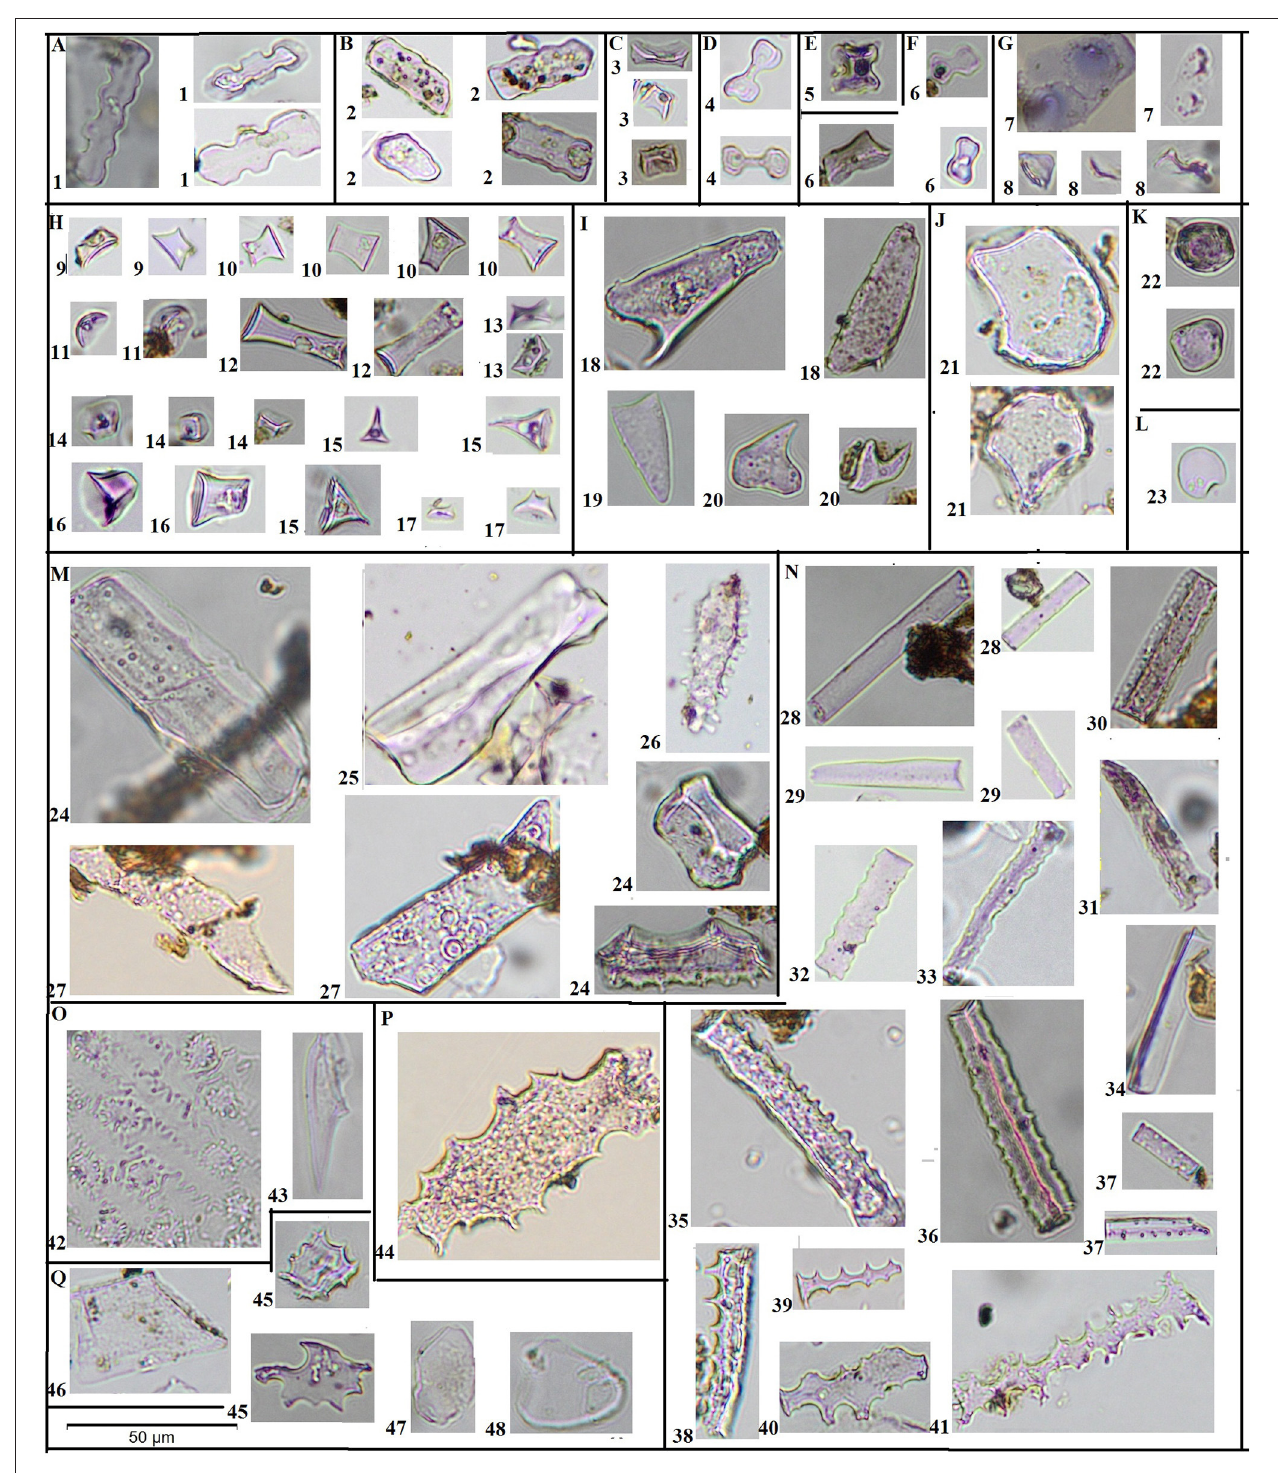
FIGURE 2 | Microphotographs of morphotypes. Microphotographs of all phytolith morphotypes used in this study. Scale bar = 50 µ m and applies to all photographs. A1—polylobate trapeziforms; B2—wavy plates; C3—saddles; D4—True bilobates (Panicoid); E5—cross (symmetrical quadrilobate); F6—trapeziform bilobate (“ Stipa -type”); G7 conical of Carex , G8—conical with wavy bottom, H—rondels, including H9—low conical rondel, H10—tall conical rondel, H11—spherical bottom rondel, H12—elongated rondel; H13—saddle-top rondel; H14—low trapezoid (pyramidal) rondel; H15—single-keeled rondel; H16—tall trapezoid (pyramidal) rondel; H17—multiple keeled rondel; I—lanceolates (trichomes), including I18—with large base and short awn; I19—triangular, I20—with small base and long awn;